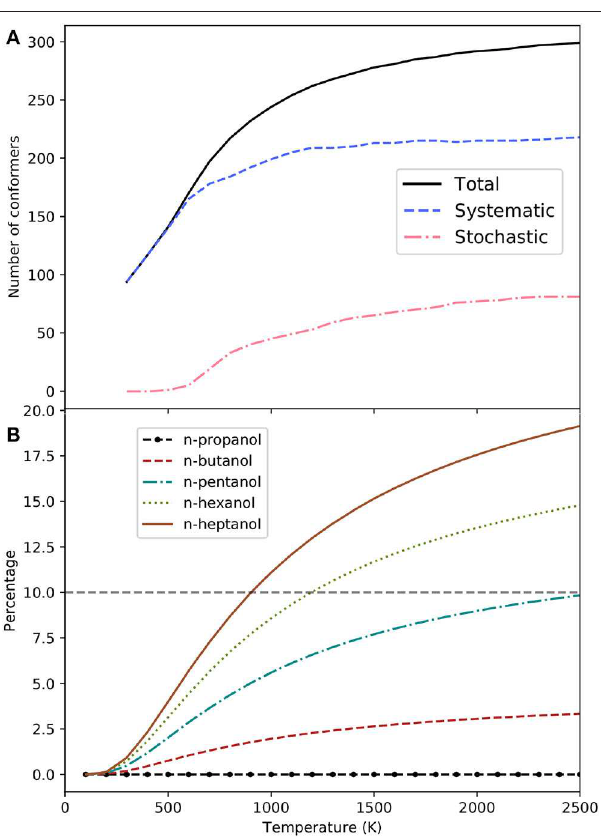
FIGURE 3 | (A) Minimum number of n-heptanol conformers needed to achieve j χ j ≥ 0.9 (solid line). Conformers collected by the systematic (dashed line) and stochastic (dash-dotted line) method are also indicated. P (B) Contribution to the MS-QH partition function of the conformers found during the stochastic search of n-alcohols.